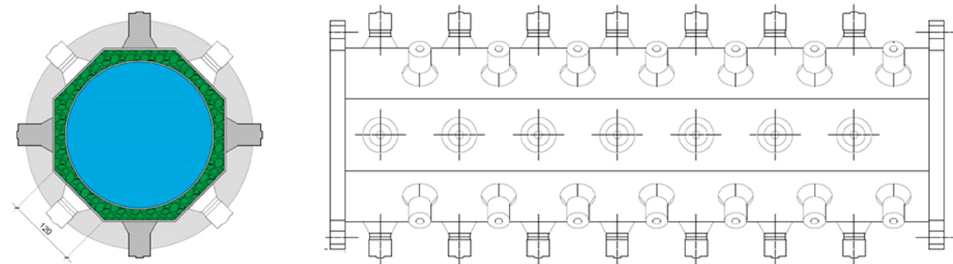
Figure 4. The device has been designed with an octagonal section equipped with a plate transducer, each of 100 W of power and 23 kHz of frequency. The inner circular section is the heat exchanger. The olive paste flows in the external annular section, while the water (cold or hot) flows in the internal annular section to modulate the temperature inside the olive paste.